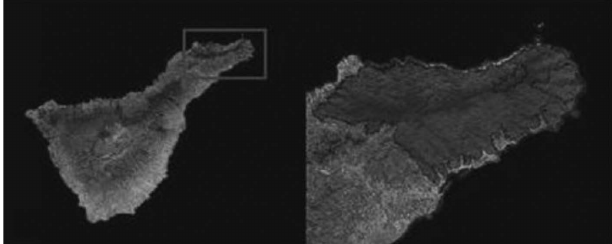
Figure 2 – Location of Anaga Rural Park on Tenerife (Canary